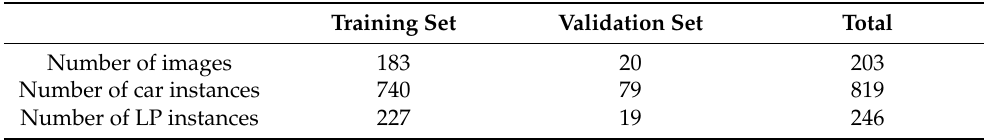
Table 2. Number of images and instances in the training and validation datasets for car and license plate